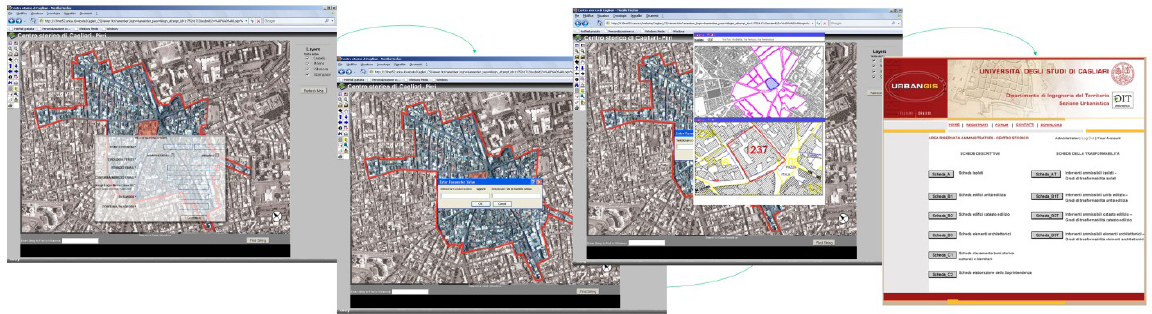
Figure 2. The structured